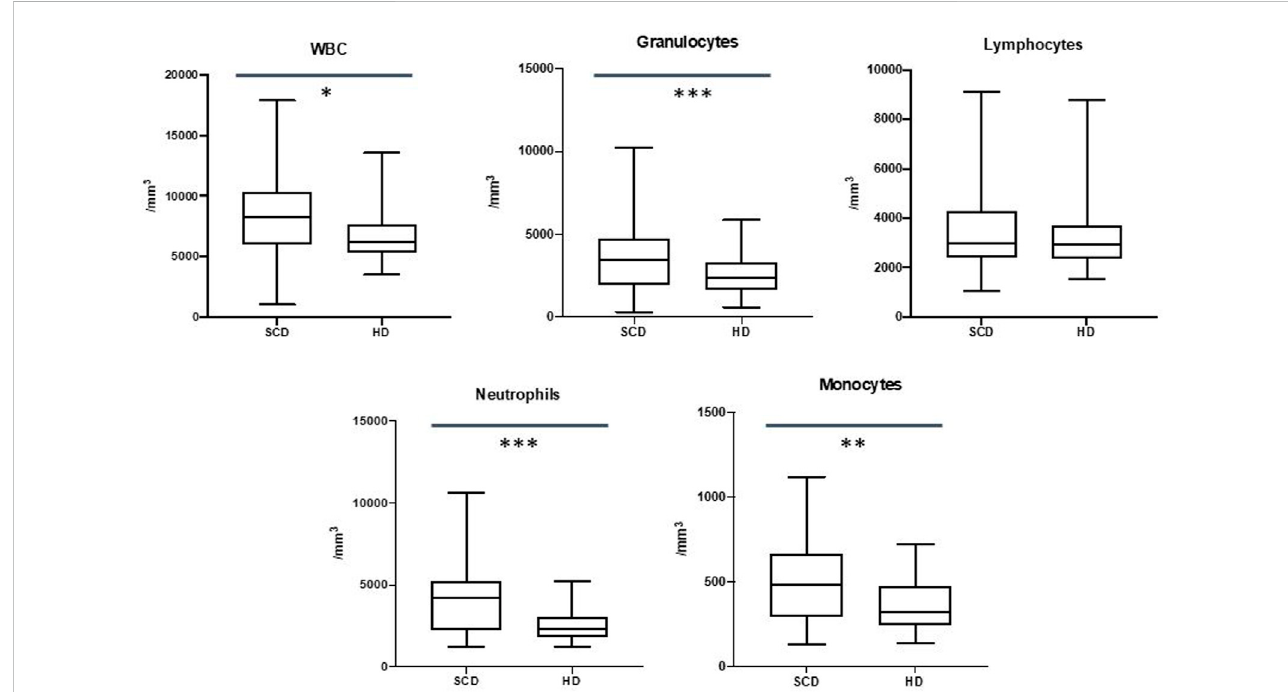
FIGURE 1 Differences in white blood cells (WBC), granulocytes, lymphocytes, neutrophils and monocytes between sickle cell disease (SCD) patients and healthy donors (HD). * p ≤ .05; ** p ≤ .01; *** p ≤ .001.